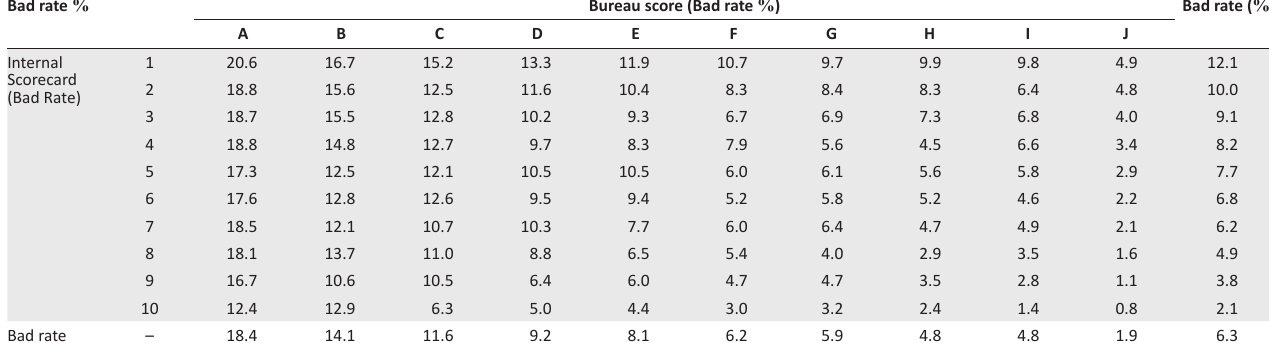
(high internal application scores and high Empirica scores). Top right and bottom left quadrant are marginal client bad rates with either a low internal application score or high Empirica score (top right quadrant) or high internal application score and low Empirica score (bottom left quadrant).